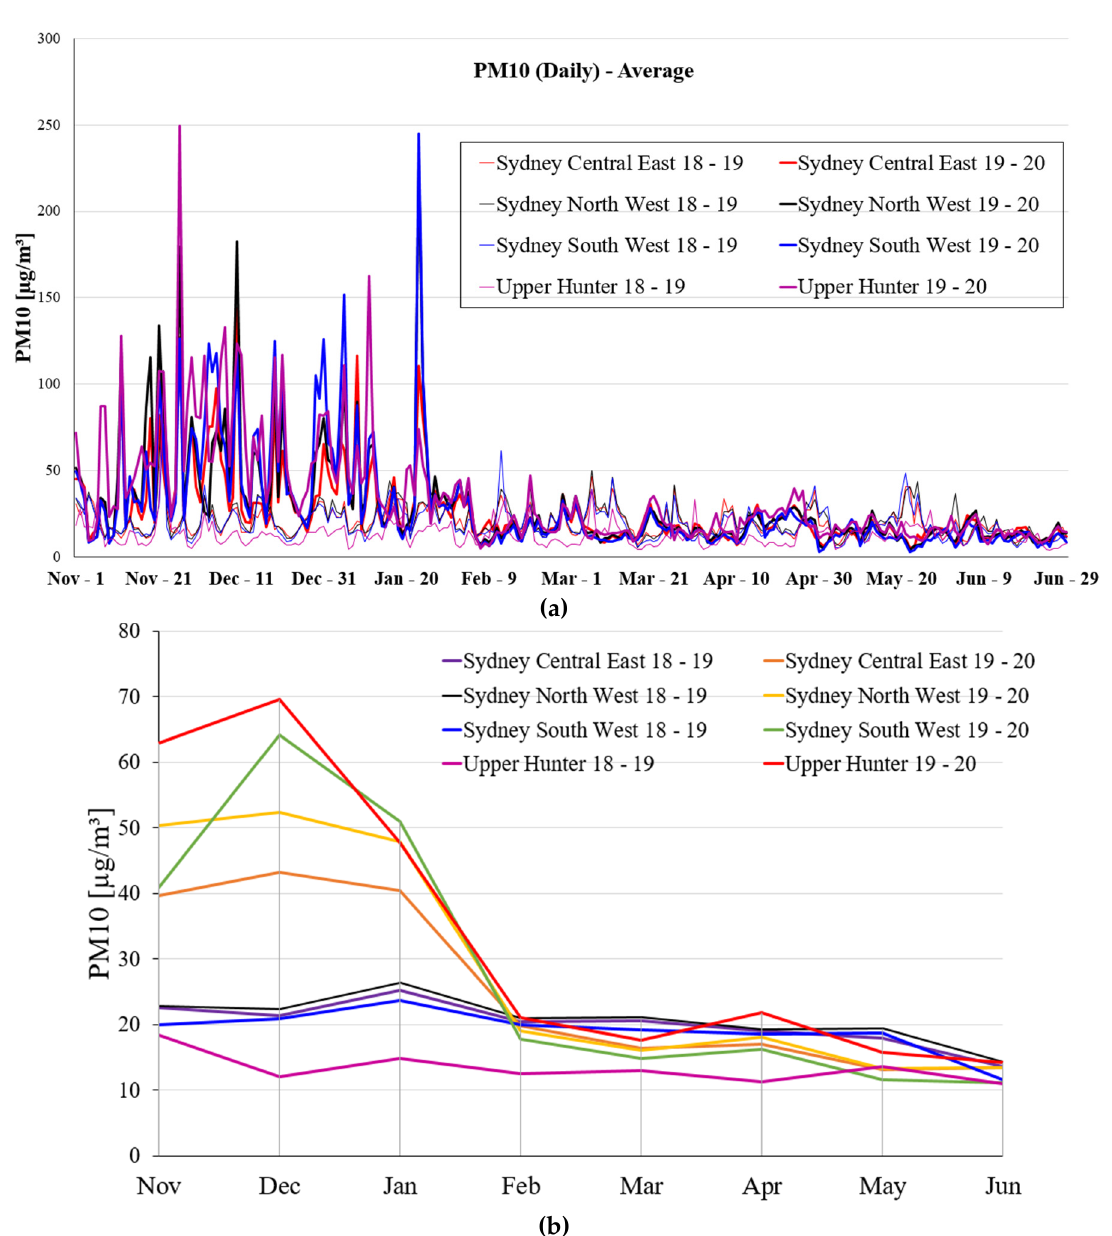
Figure 10. The average PM 10 emission in Sydney Central East, North West, South West, and Upper Hunter region for a period of eight months during 2018–2019 and 2019–2020, ( a ) daily PM 10 emission, and ( b ) monthly PM 10